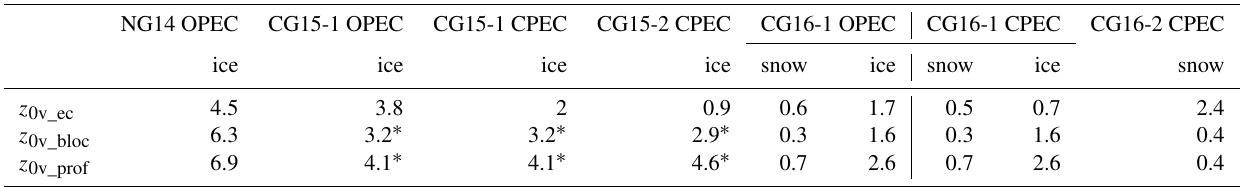
Table 6. Comparison of momentum roughness length values (in millimetres) for each station, as observed from the EC systems ( z 0v_ec ) and as estimated using the DEM-based methods ( z 0v_bloc and z 0v_prof ).